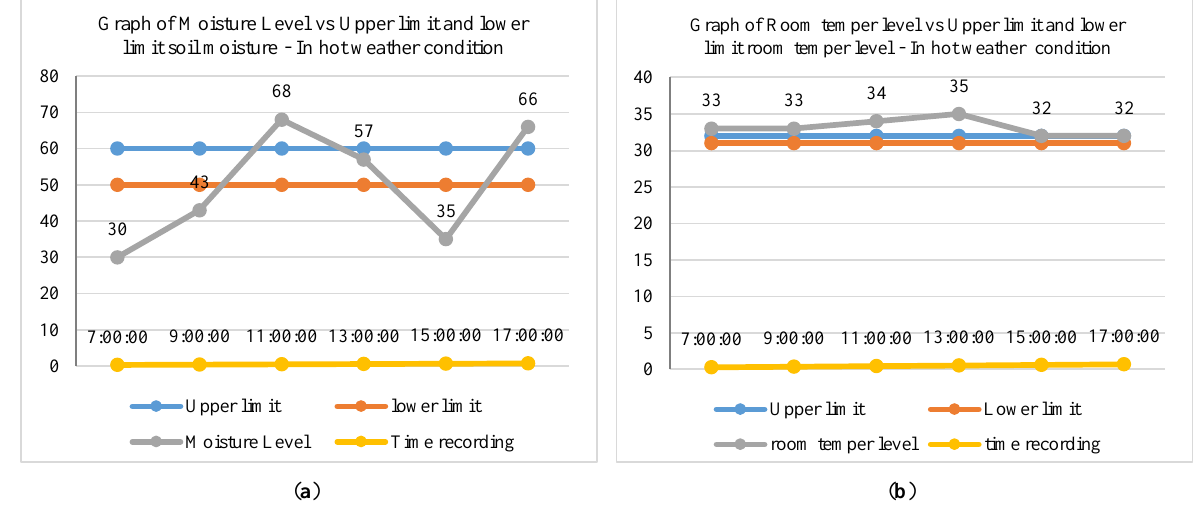
Figure 10. (a) Graph of Moisture Level; (b) Graph of Room temperature level. Table 5. Testing of soil moisture control in hot weather.